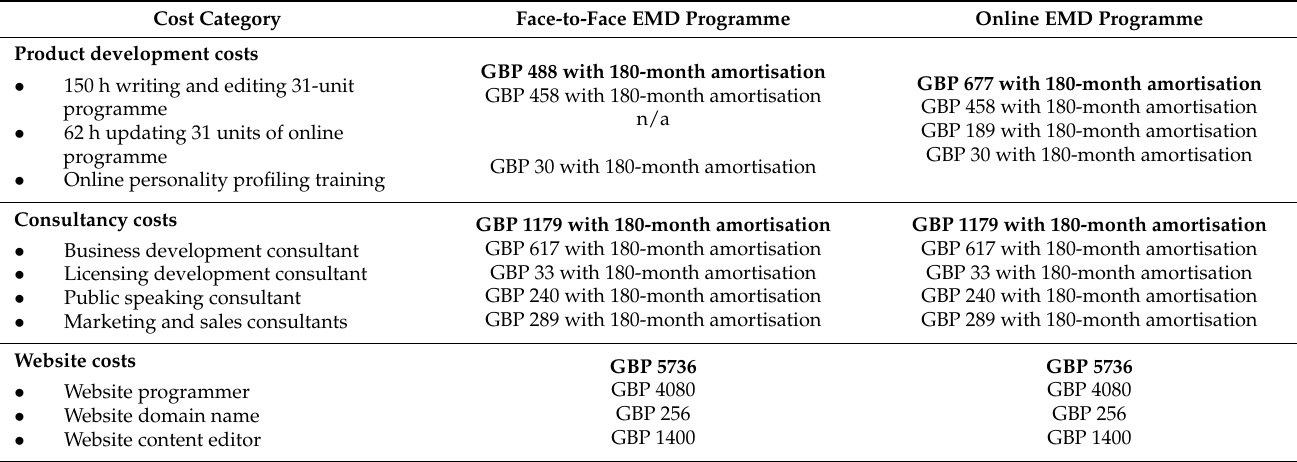
Table 5. Annual costs to deliver the EMD